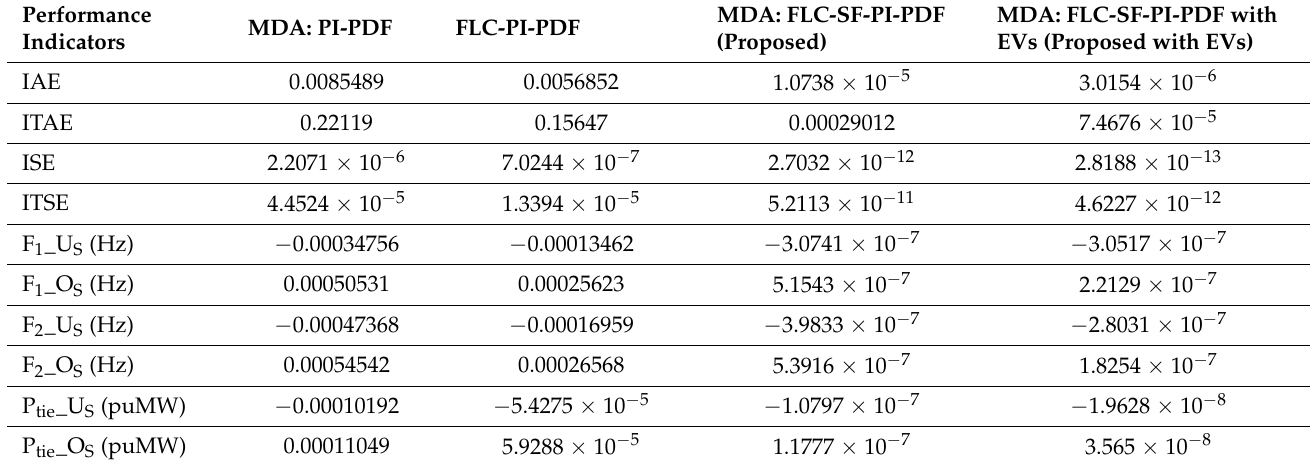
Figure 10. ( a ) Power responses of MG components of area 1. ( b ) Power responses of MG components of area 2.